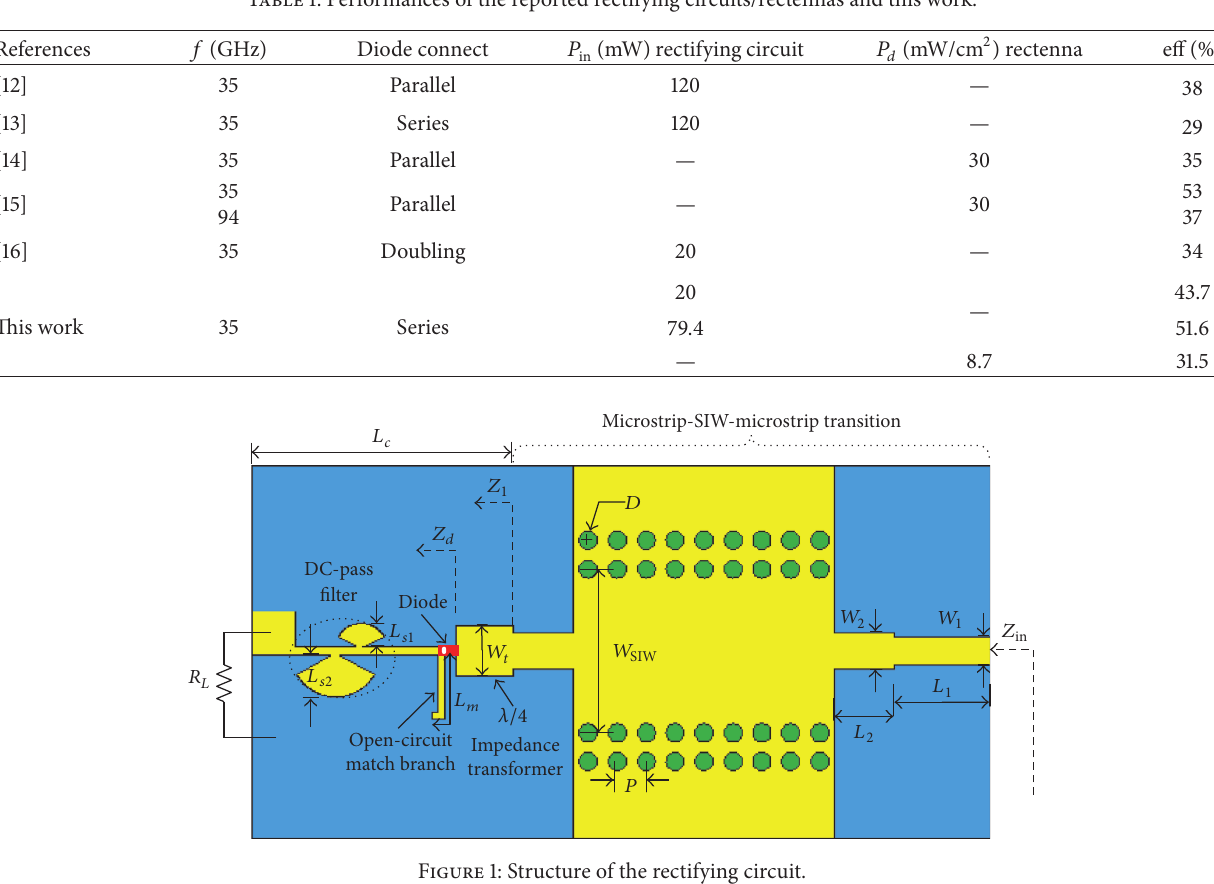
Table 1: Performances of the reported rectifying circuits/rectennas and this work.